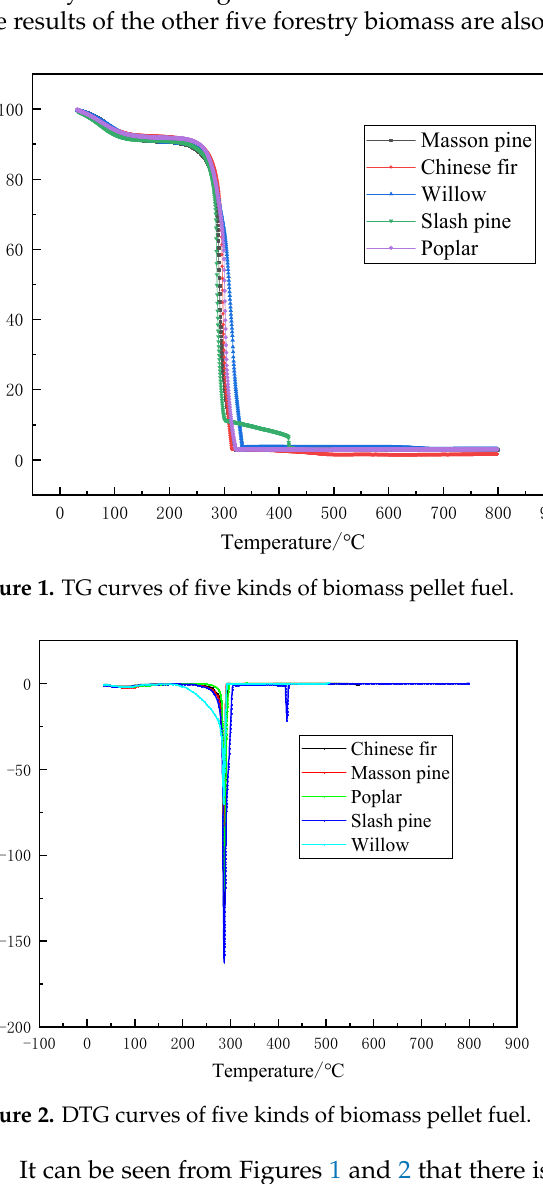
Figure 2. DTG curves of five kinds of biomass pellet fuel.